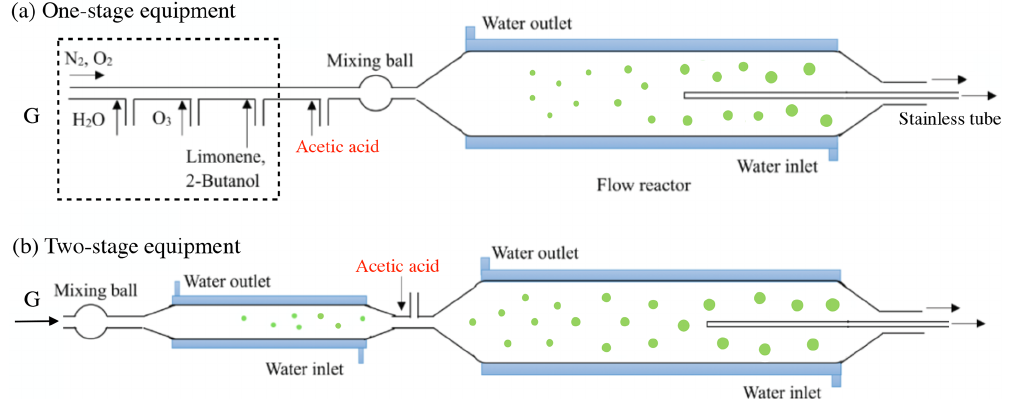
Figure 1. Diagram of the experimental setup. The (a) one-stage and (b) two-stage apparatuses are used to investigate the first- and second- generation oxidation. The green circles represent the process of SOA growth.